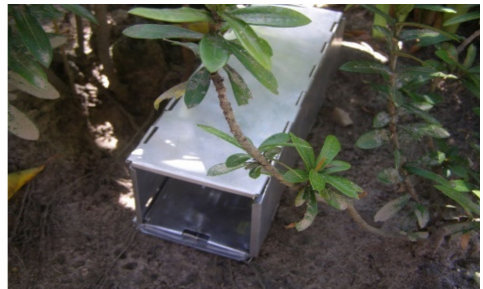
Figure 1. Sherman-type trap.